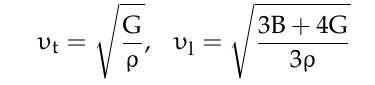
Table 2. Computed values of elastic constants C 11 , C 12 , C 44 in (GPa), bulk modulus B (GPa),